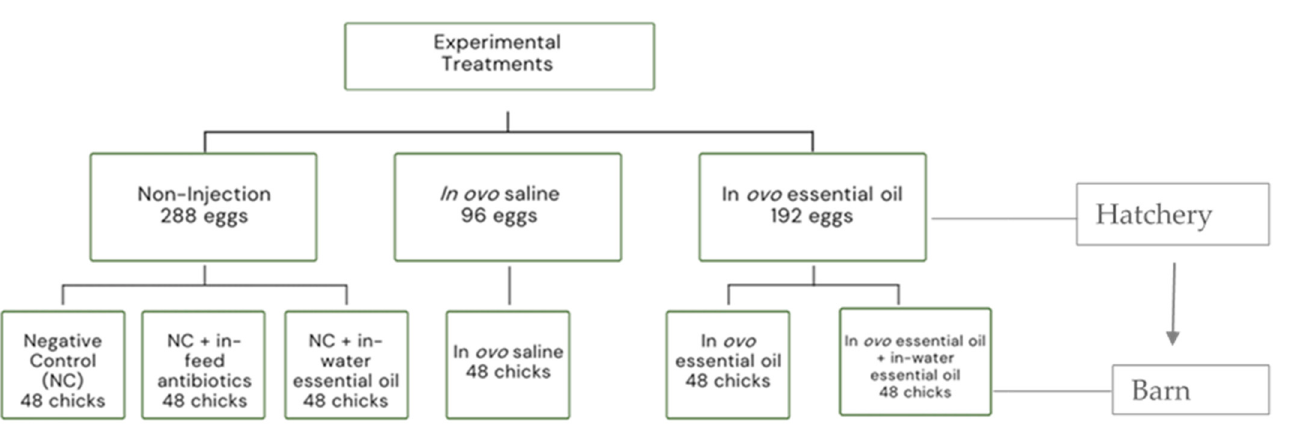
Figure 1. Schematic presentation of experimental structure in the hatchery and barn.